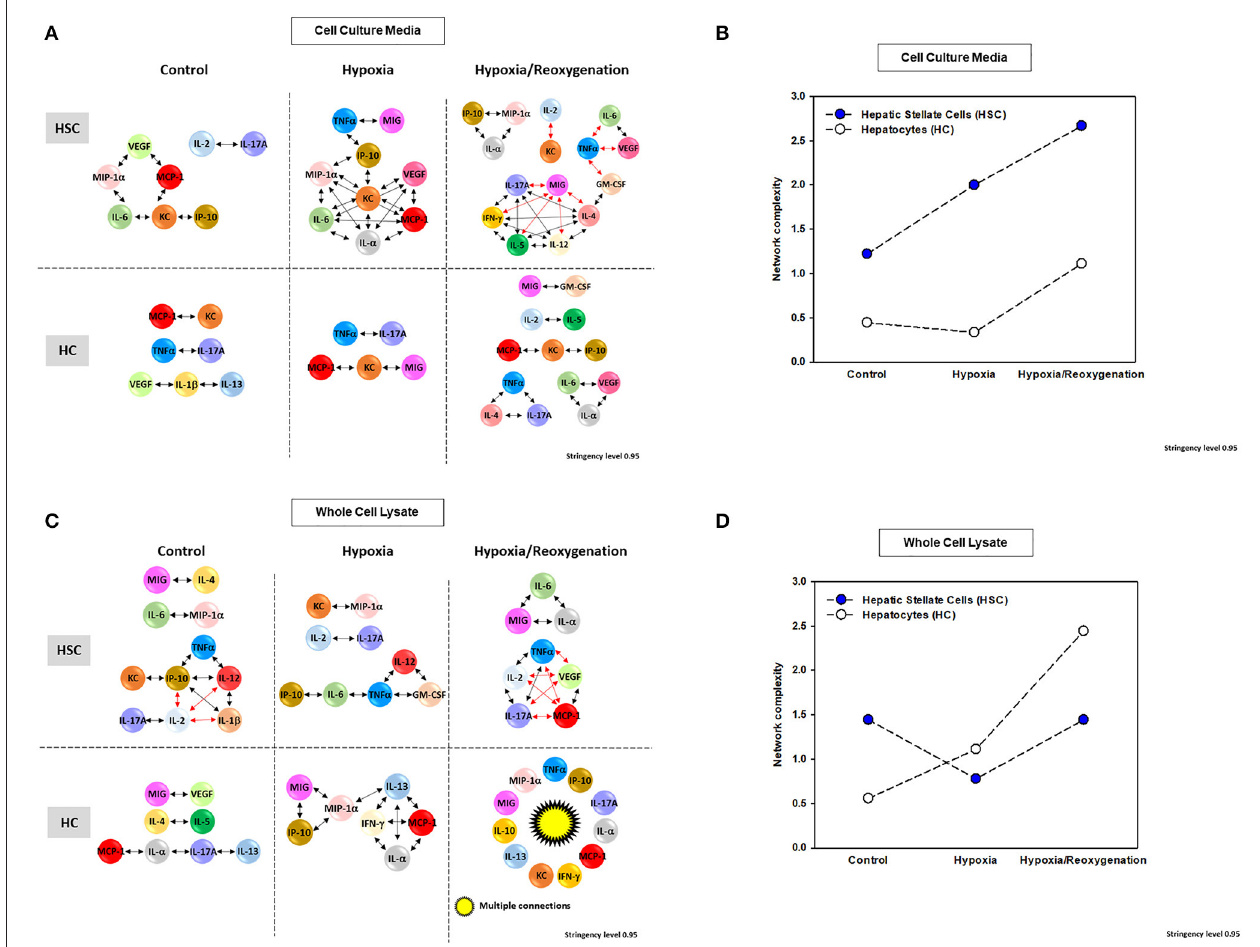
FIGURE 5 | Network Analysis of inflammatory mediators in mouse hepatic stellate cells (HSC) and hepatocytes (HC) Freshly isolated HSC and HC from C57BL/6 mice were cultured under 21% O 2 for 6h (control), hypoxia (1% O 2 ) for 6h or hypoxia (6h) followed by reoxygenation for 18h. Inflammatory mediators released into cell culture media (CCM) and in whole cell lysate (WCL) were measured by Luminex TM and Network Analysis was performed as described in Materials and Methods . Figure shows the networks and the detailed connectivity (stringency level 0.95) for each experimental condition in both cell types in CCM (A) and WCL (C) . Black and red arrows represent positive and negative connections, respectively. (B,D) Show the network complexity in HSC vs. HC for CCM and WCL,